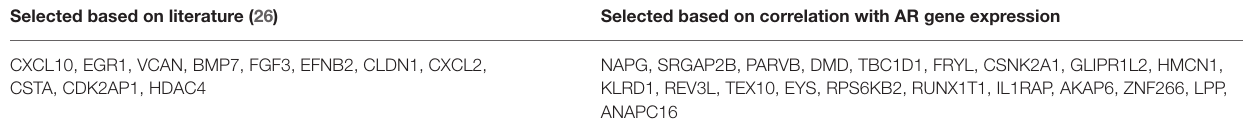
TABLE 2 | Selected genes for testosterone-sensitivity. Selected based on literature (26) Selected based on correlation with AR gene expression